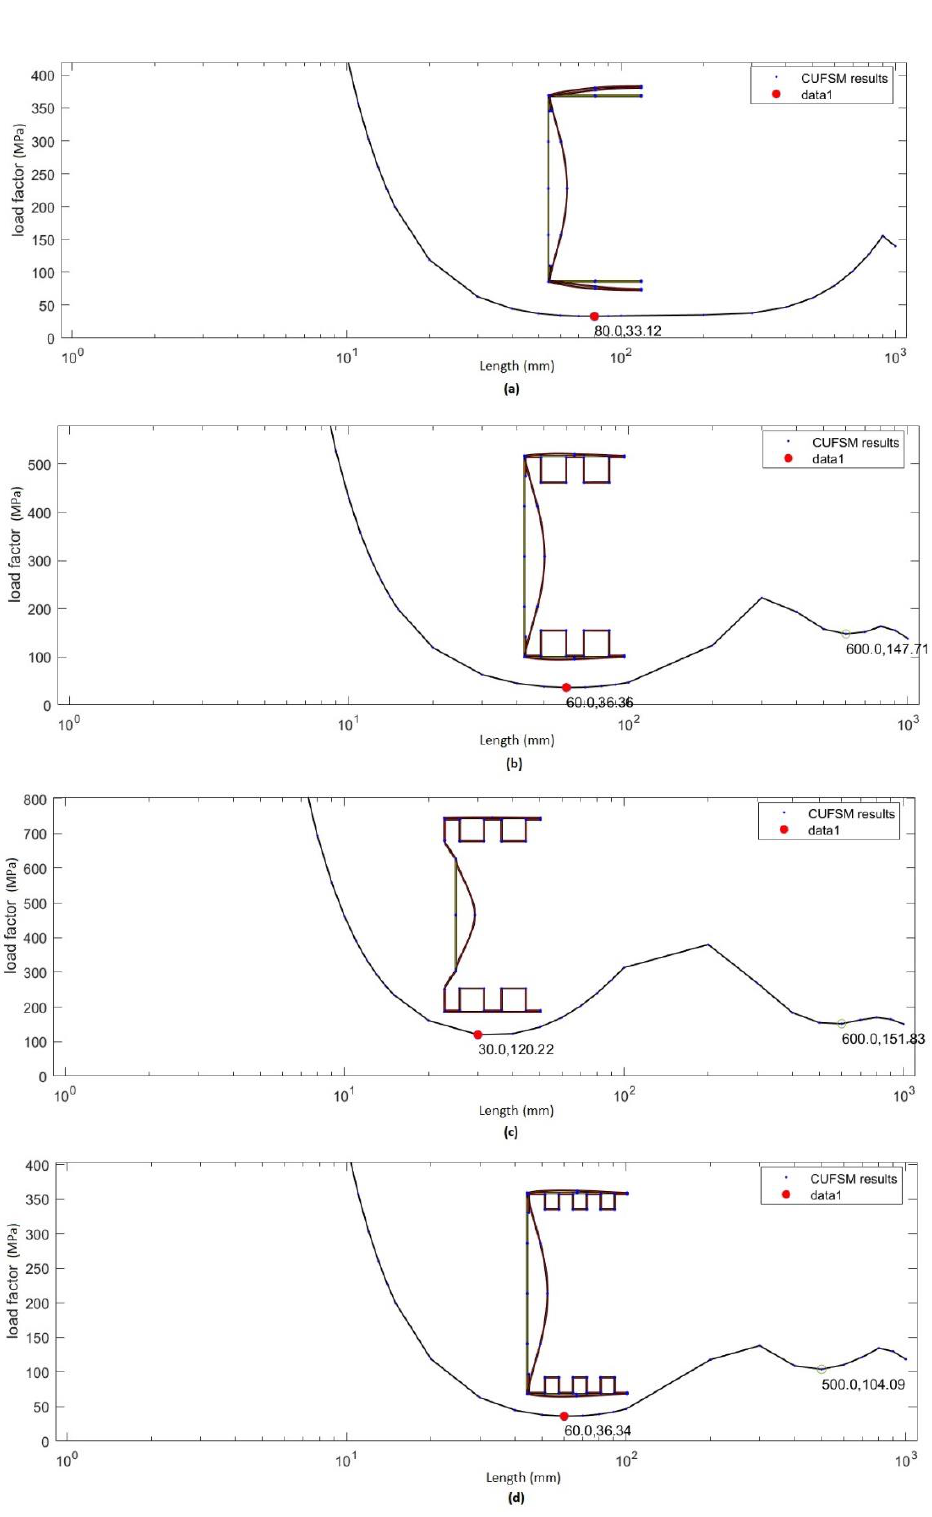
Figure 12. Results of the simulation carried out using the finite strip method: ( a ) Results for column B1. ( b ) Results for column B2. ( c ) Results for column B3. ( d ) Results for column B4.